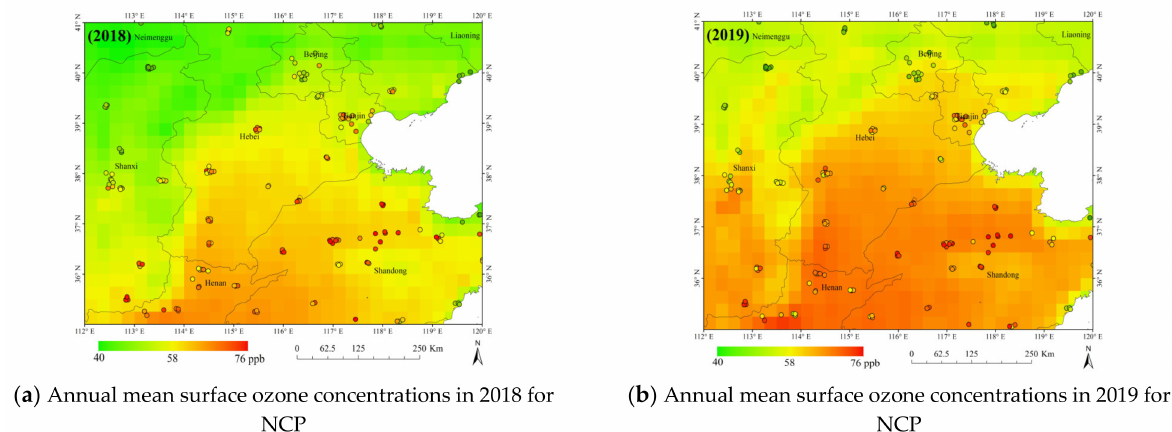
Figure 12. The map of 0.25 ◦ × 0.25 ◦ annual mean surface ozone concentrations in 2018 ( a ) and 2019 ( b ) for SCB; the colored dots represent the annual mean of concentrations of each surface ozone site from CNEMC.